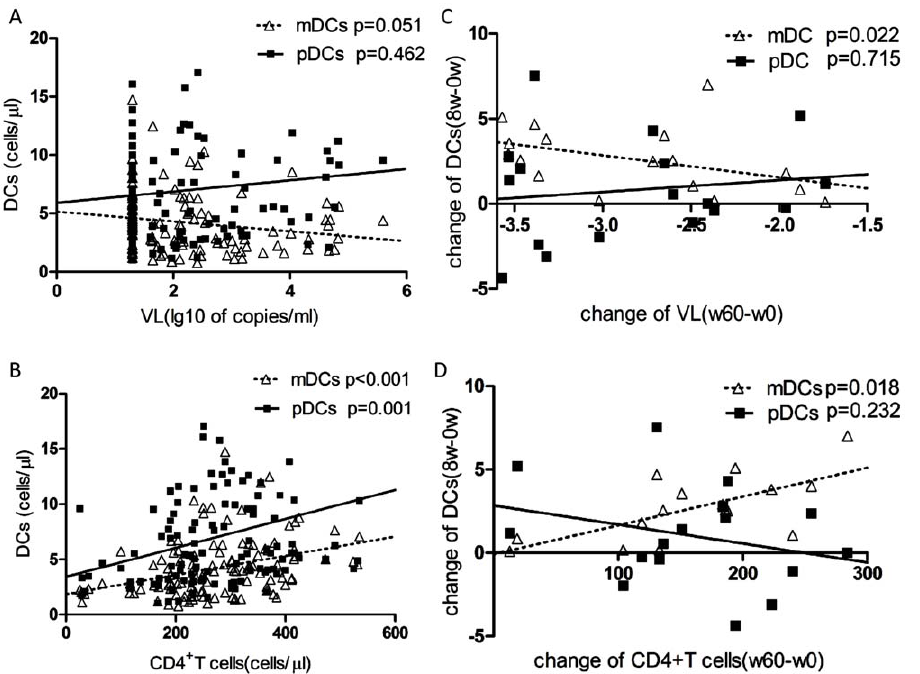
Figure 2. The association of DC subsets with viral loads and CD4 + Tcells. (A–B) Correlation between DC subsets counts and plasma viral loads, CD4 + Tcells counts during ART. (C–D) Correlation between change in counts of DC subsets at week 8 and the change in plasma viral loads, CD4 + Tcells counts at week 60 post ART.